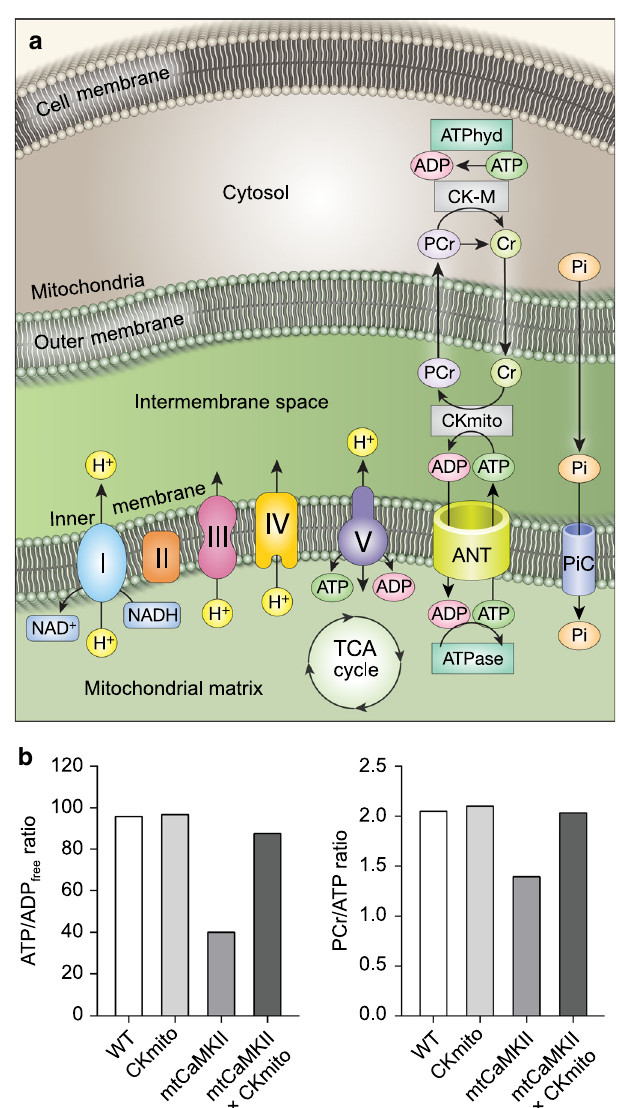
Fig. 7 Computational modeling of energetics. a Schematic image of key parameters used in a three compartment model of CaMKII, creatine kinase (CK), and mitochondrial energetics. b Computer stimulation results were compared in WT, CKmito, mtCaMKII, and mtCaMKII x CKmito interbred conditions. The ratios of PCr/ATP and ATP/ADP were calculated at the end of 5 min cardiac cycle (simulated using pulsatile functions to oscillate ATP hydrolysis and cytosolic